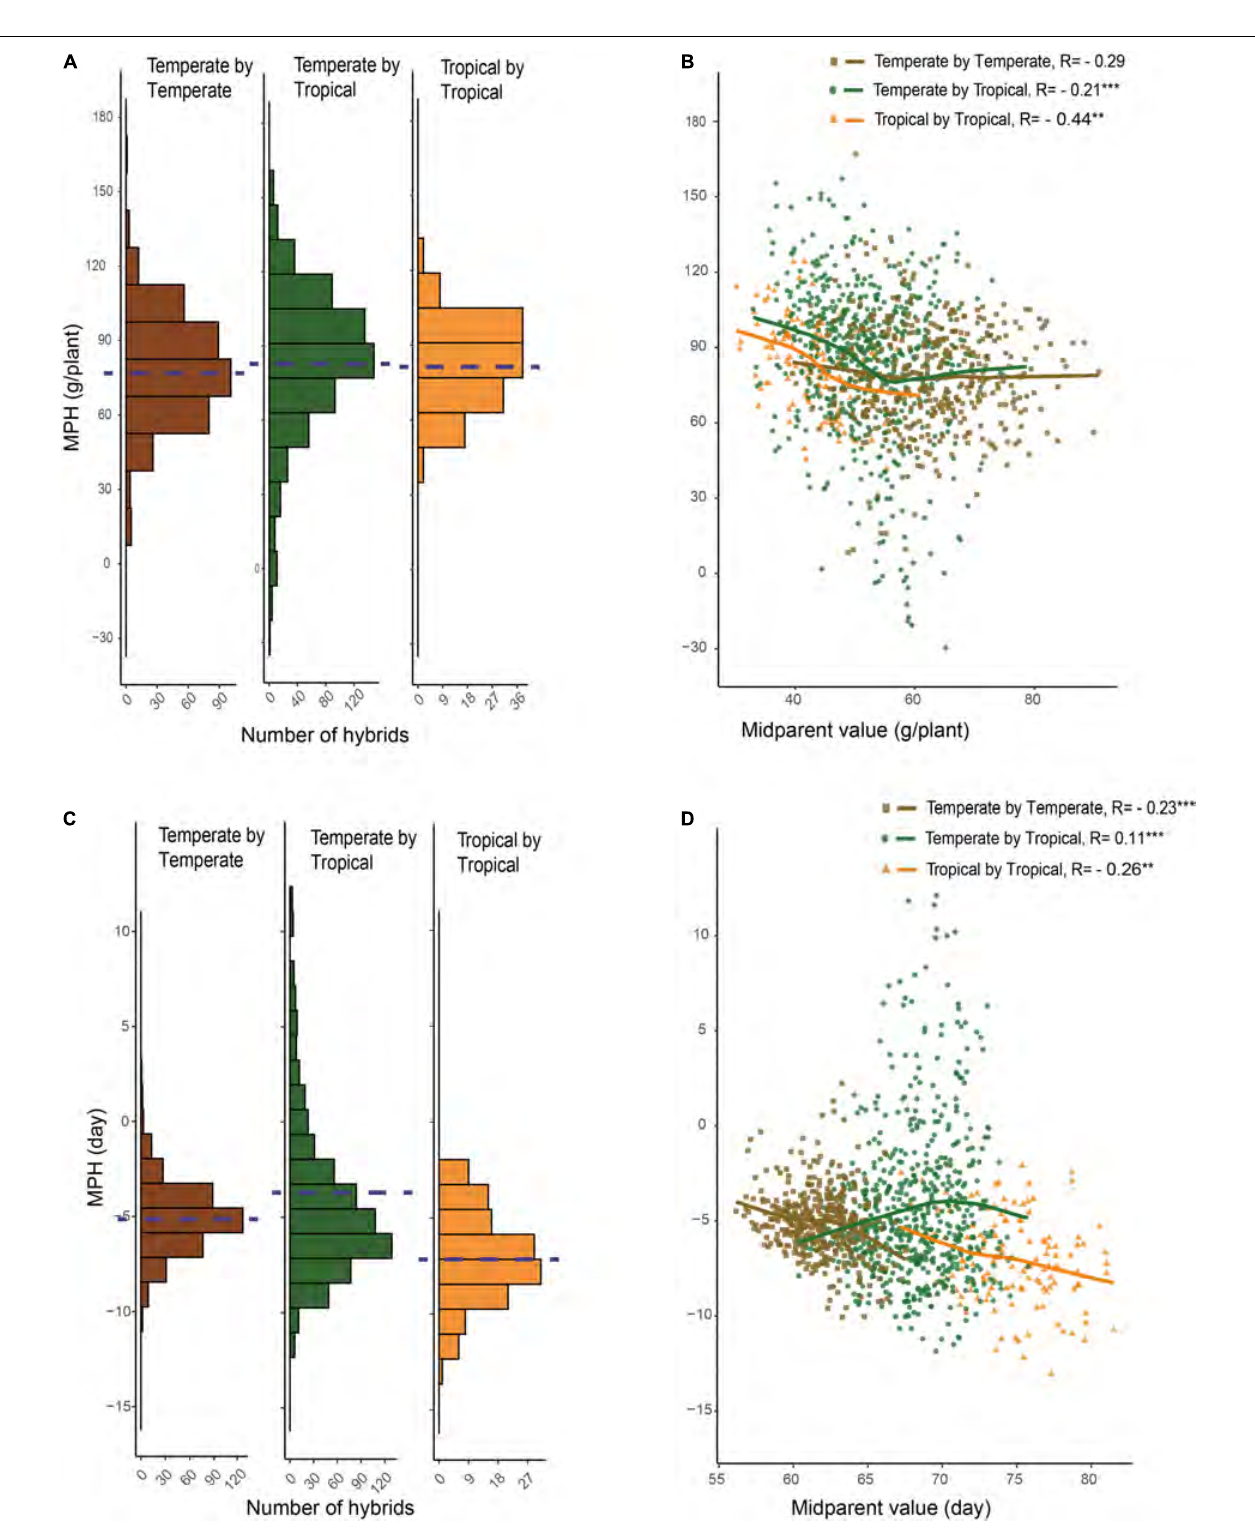
FIGURE 2 | Relationship between hybrid heterosis and mid-parent performance. (A) Mid-parent heterosis (MPH) of GWPP for temperate by temperate, temperate by tropical, and tropical by tropical hybrids. (B) Relationship between MPH and mid-parent (MP) performance for GWPP. (C) Distribution of MPH for days to silking for temperate by temperate, temperate by tropical, and tropical by tropical hybrids. (D) Relationship between MPH and MP performance for days to silking. The dashed lines in the histograms indicate the averages.